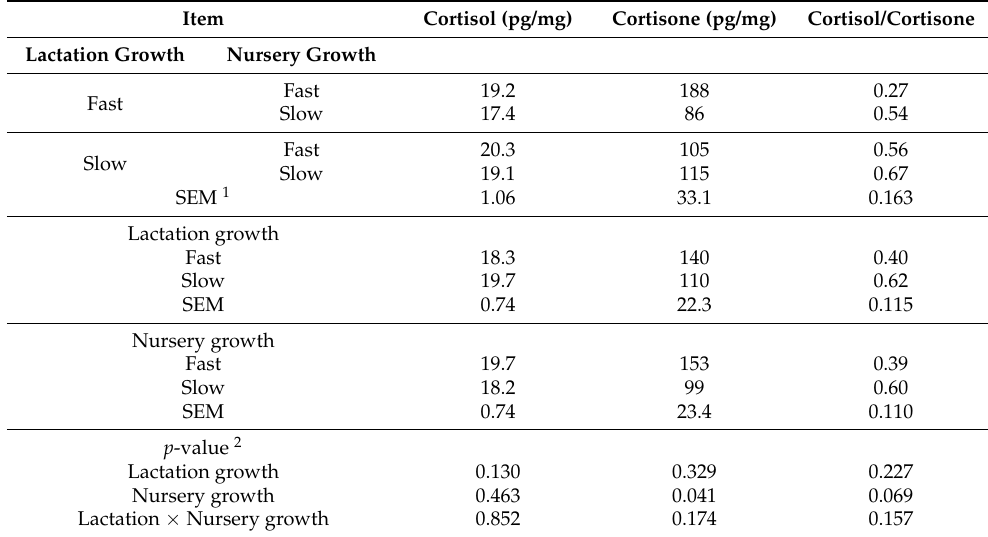
Table 3. Cortisol and cortisone concentration levels in hair and calculated cortisol-to-cortisone ratio for each growth group.